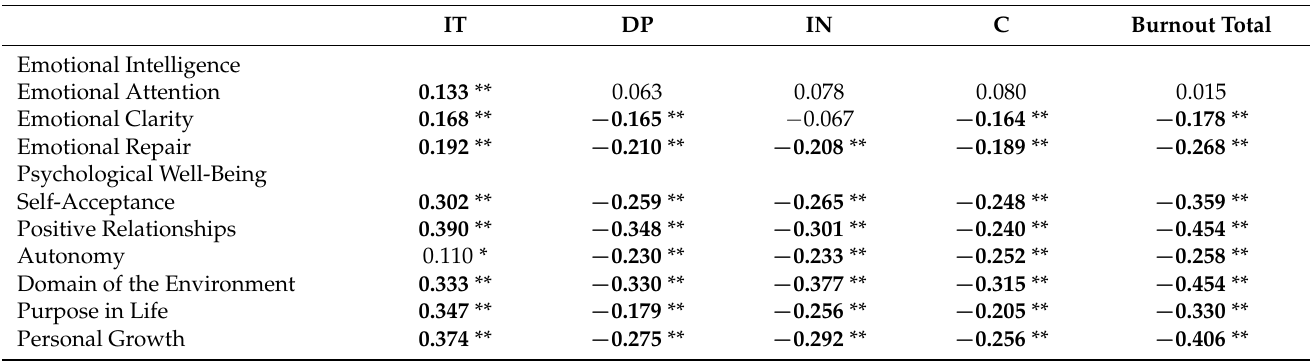
Table 1. Relationship between emotional intelligence and psychological well-being and burnout in active teachers and